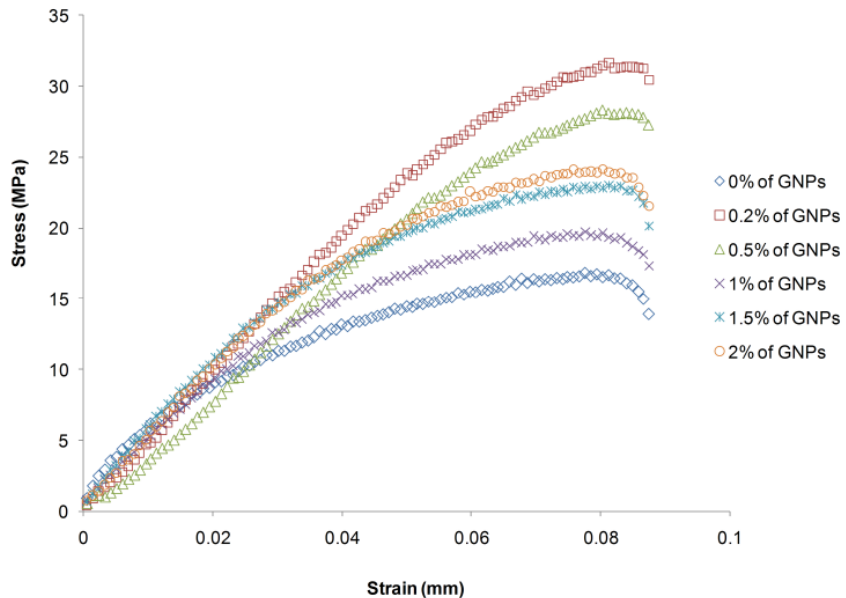
Figure 4. Stress-strain curves from tensile test.